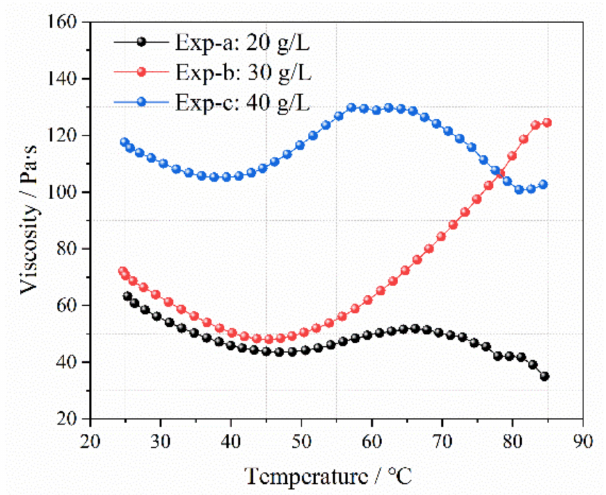
Figure 9. Viscosity with increasing temperature at different Ca-Bt